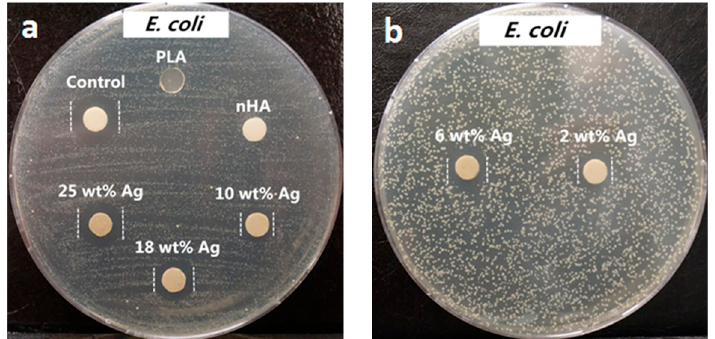
Figure 9. Macrographs of agar plates showing bacterial inhibition zones against E. coli : ( a ) control (AgNO 3 ), PLA, PLA/18 wt% nHA, PLA/18 wt% nHA–10 wt% AgNPs, PLA/18 wt% nHA–18 wt% AgNPs and PLA/18 wt% nHA–25 wt% AgNPs samples, and ( b ) PLA/18 wt% nHA–2 wt% AgNPs and PLA / 18 wt% nHA–6 wt% AgNPs hybrid nanocomposites. Reproduced from [154], Copyright Royal Society of Chemistry,